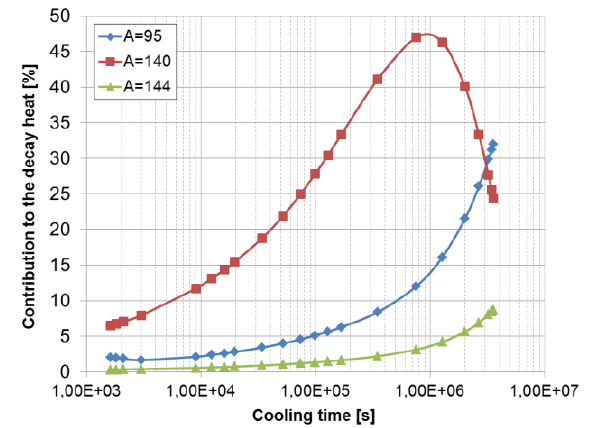
Fig. 3. Contributions of the main contributing masses to the decay heat [%] over the cooling time [s] for the MERCI-1